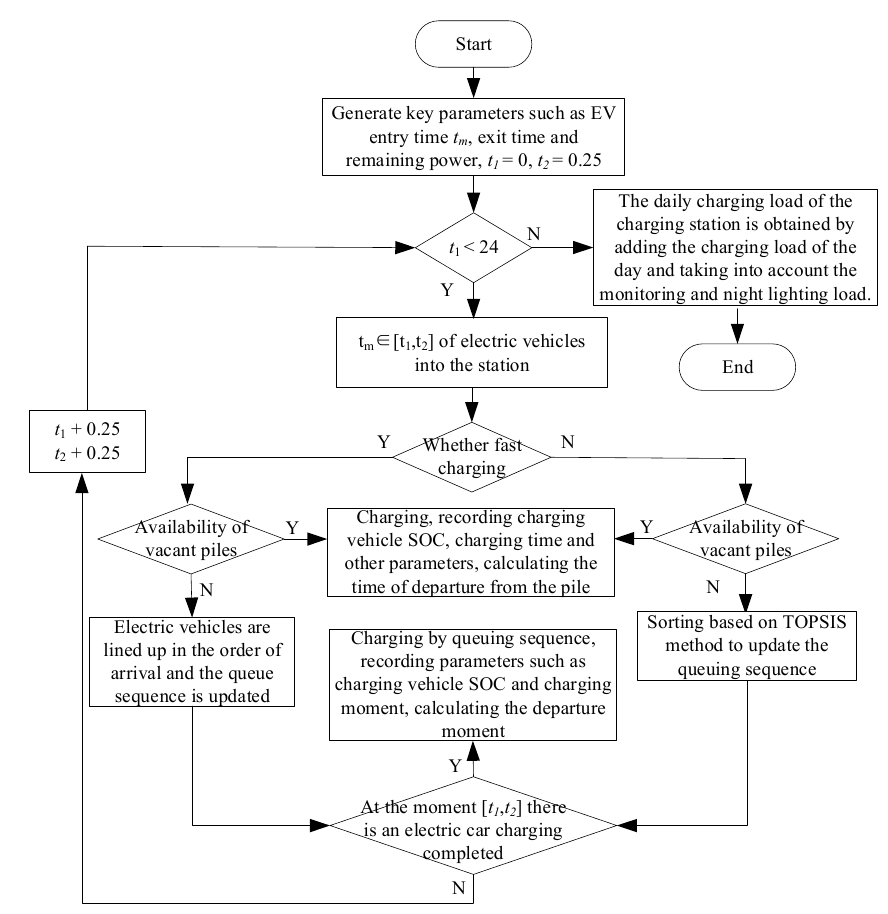
Figure 5. Flowchart of charging station daily load model construction.